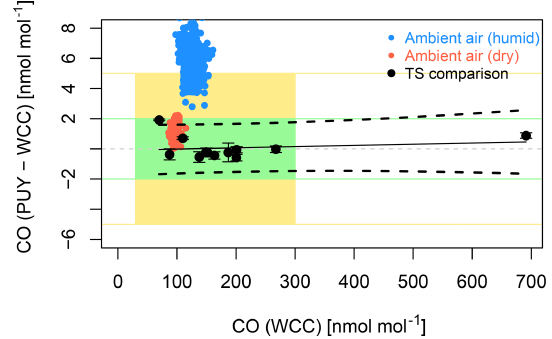
Figure 12. Bias of the PUY Picarro G2401 CO instrument vs. WCC-Empa assigned values. Black dots represent the average of the data at a given level from a specific TS comparison. The error bars show the standard deviation of individual measurement points. The green and yellow lines correspond to the WMO network com- patibility and extended network compatibility goals, and the green and yellow areas to the amount fraction range relevant for PUY. The dashed lines around the regression lines are the Working–Hotelling 95 percentage confidence intervals. The coloured dots show the bias during the ambient-air comparison without (blue) and with (red) drying of the air sampled by the